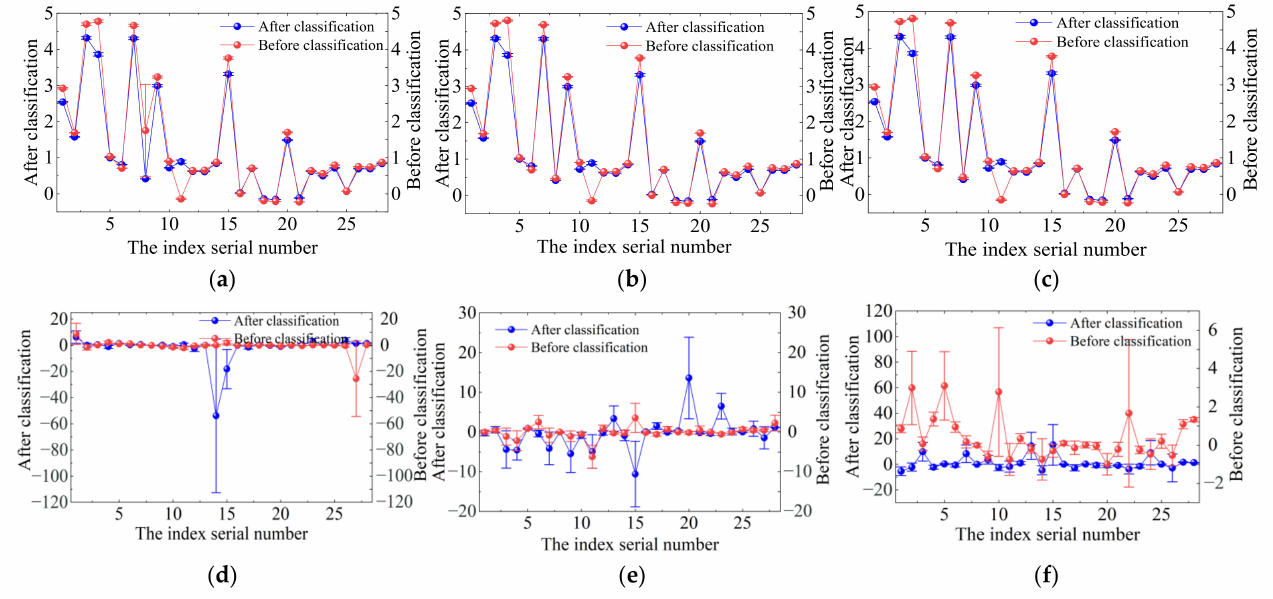
Figure 13. Change trend of some indexes before and after image pixel classification (100 m). Refer to Figure 11 for details of processing ( a – f